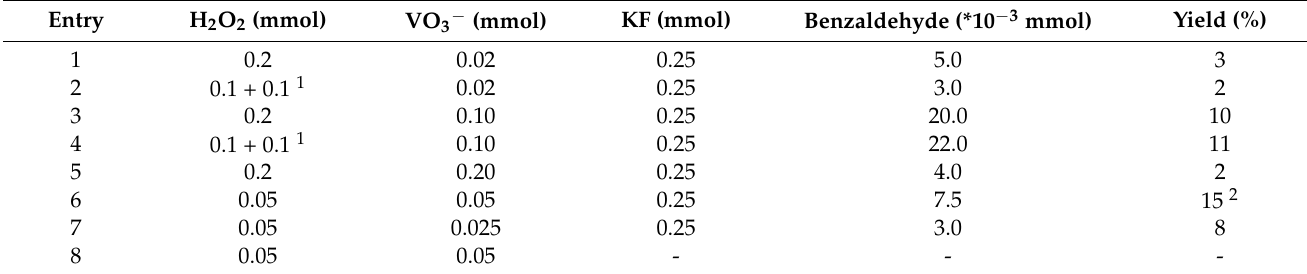
Table 1. Toluene oxidation in biphasic system (V = 20 mL; PhCH 3 :H 2 O 1:1 v/v), pH = 1, 24 h, T = 25 °C.